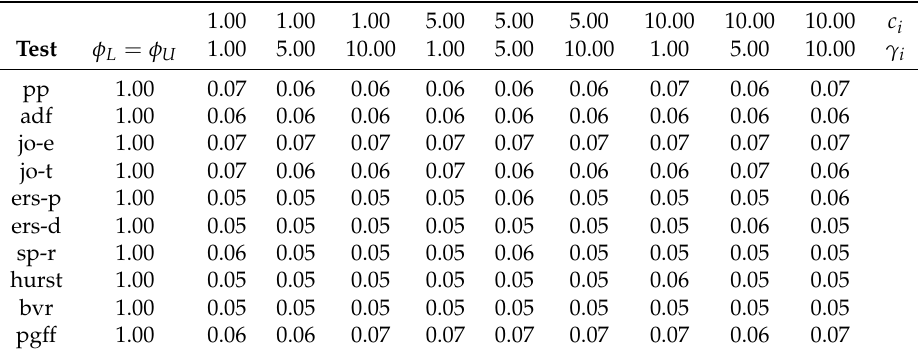
Table 10. Size of cointegration tests for Monte Carlo settings of Type IV.